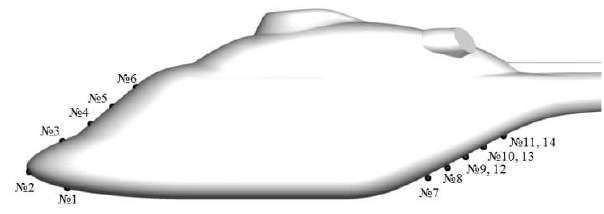
Fig. 6. High-frequency pressure probes location